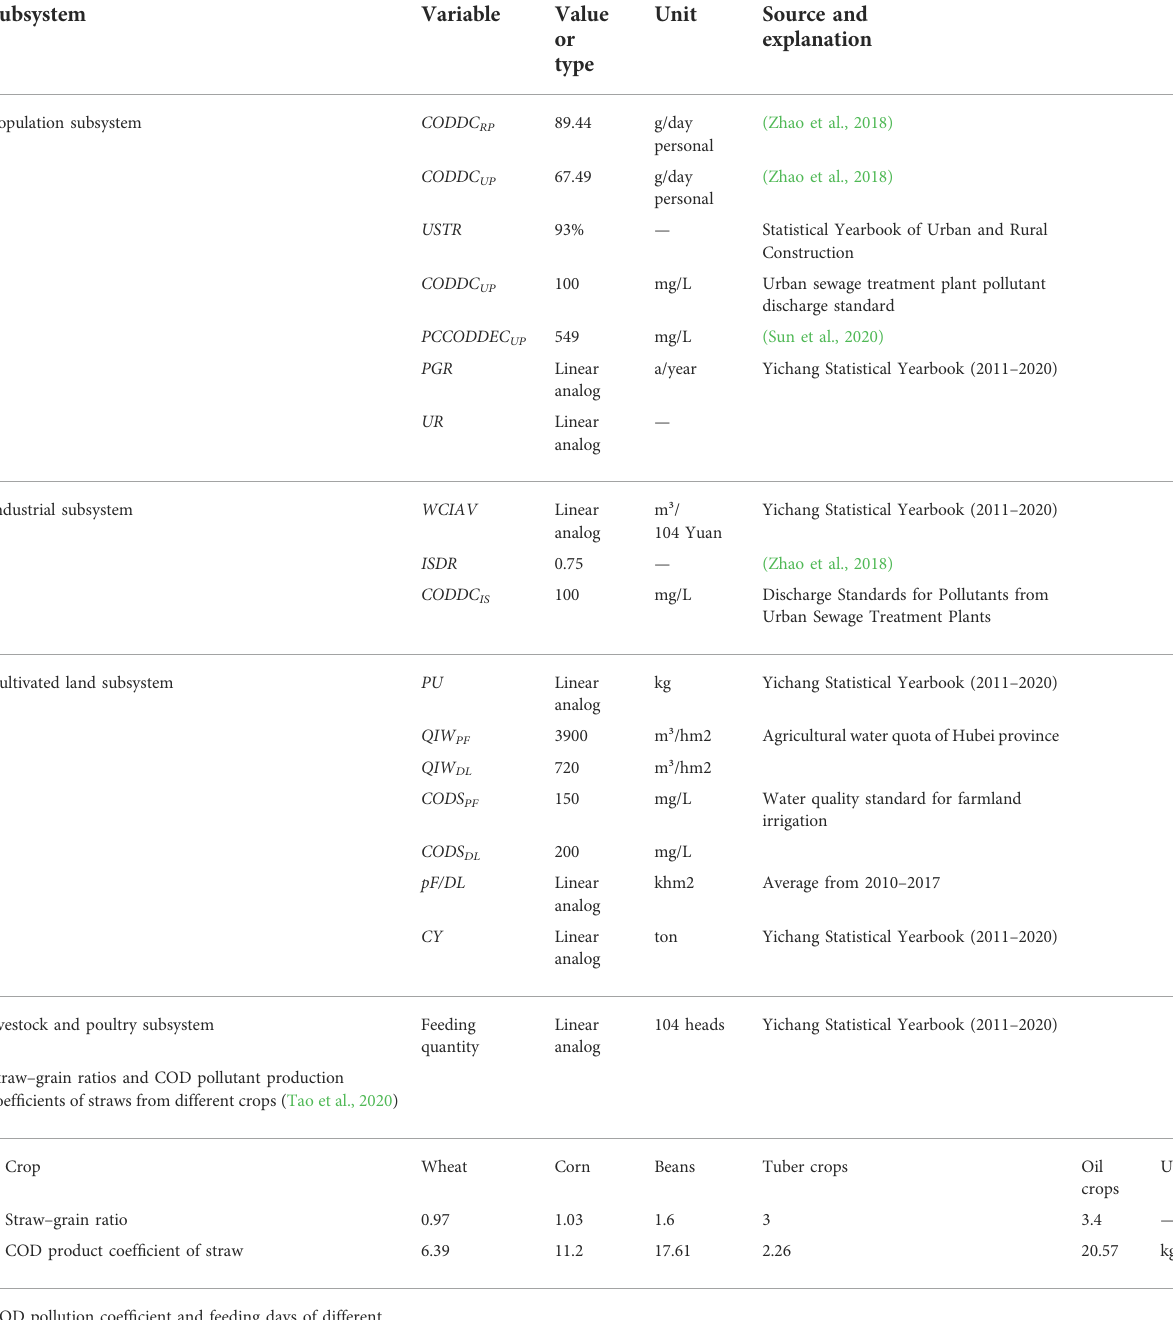
TABLE 2 Data type and